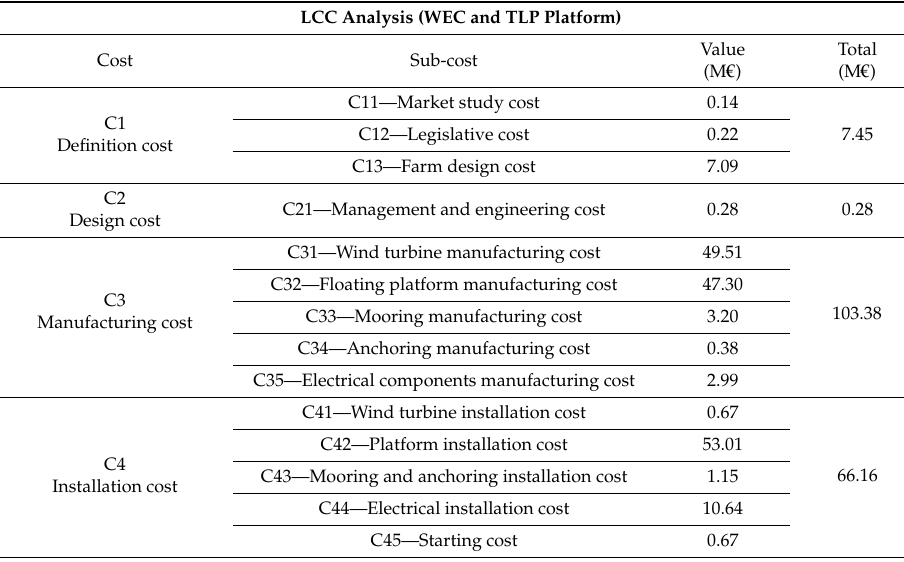
Table 6. LCC analysis for HWWF (WEC and TLP